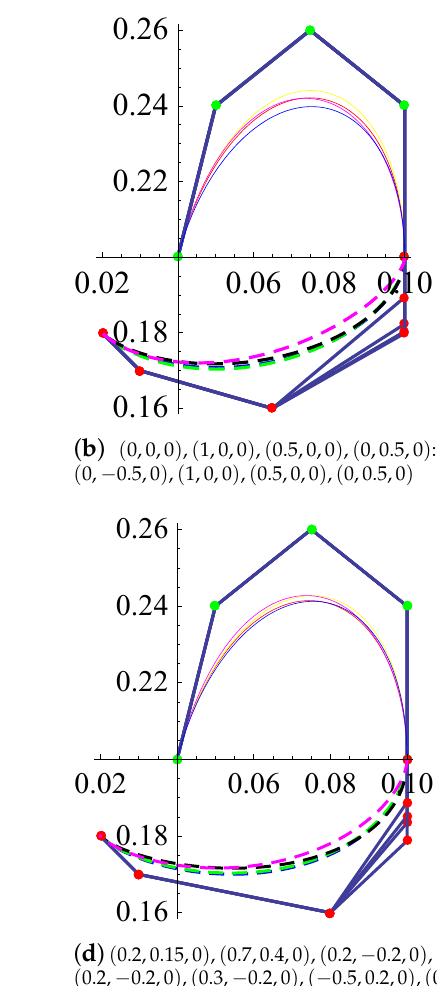
Figure 8. G 1 smooth continuity of the GHT-Bézier curve with multiple shape parameters. ( a ) ( 0,0,0 ) , ( 0,0,0 ) , ( 0,0,0 ) , ( 0,0,0 ) : ( 0,0, 0.5 ) , ( 1,0.5,0 ) , ( 0.5,0,0 ) , ( 0,0.5,0 ) ; ( b ) ( 0,0,0 ) , ( 1,0,0 ) , − ( 0.5,0,0 ) , ( 0,0.5,0 ) : ( 0, 0.5,0 ) , ( 1,0,0 ) , ( 0.5,0,0 ) , ( 0,0.5,0 ) ; ( c ) ( 0,1,0 ) , ( 1, − ( 0,1,0 ) , ( 1, 0.75,0 ) , ( 0.5,0,0 ) , ( 0, 0.5,0 ) ; ( d ) ( 0.2,0.15,0 ) , ( 0.7,0.4,0 ) , ( 0.2, − − ( 0.2, 0.2,0 ) , ( 0.3, 0.2,0 ) , ( 0.5,0.2,0 ) , ( 0.3,0.3,,0 ) − − −